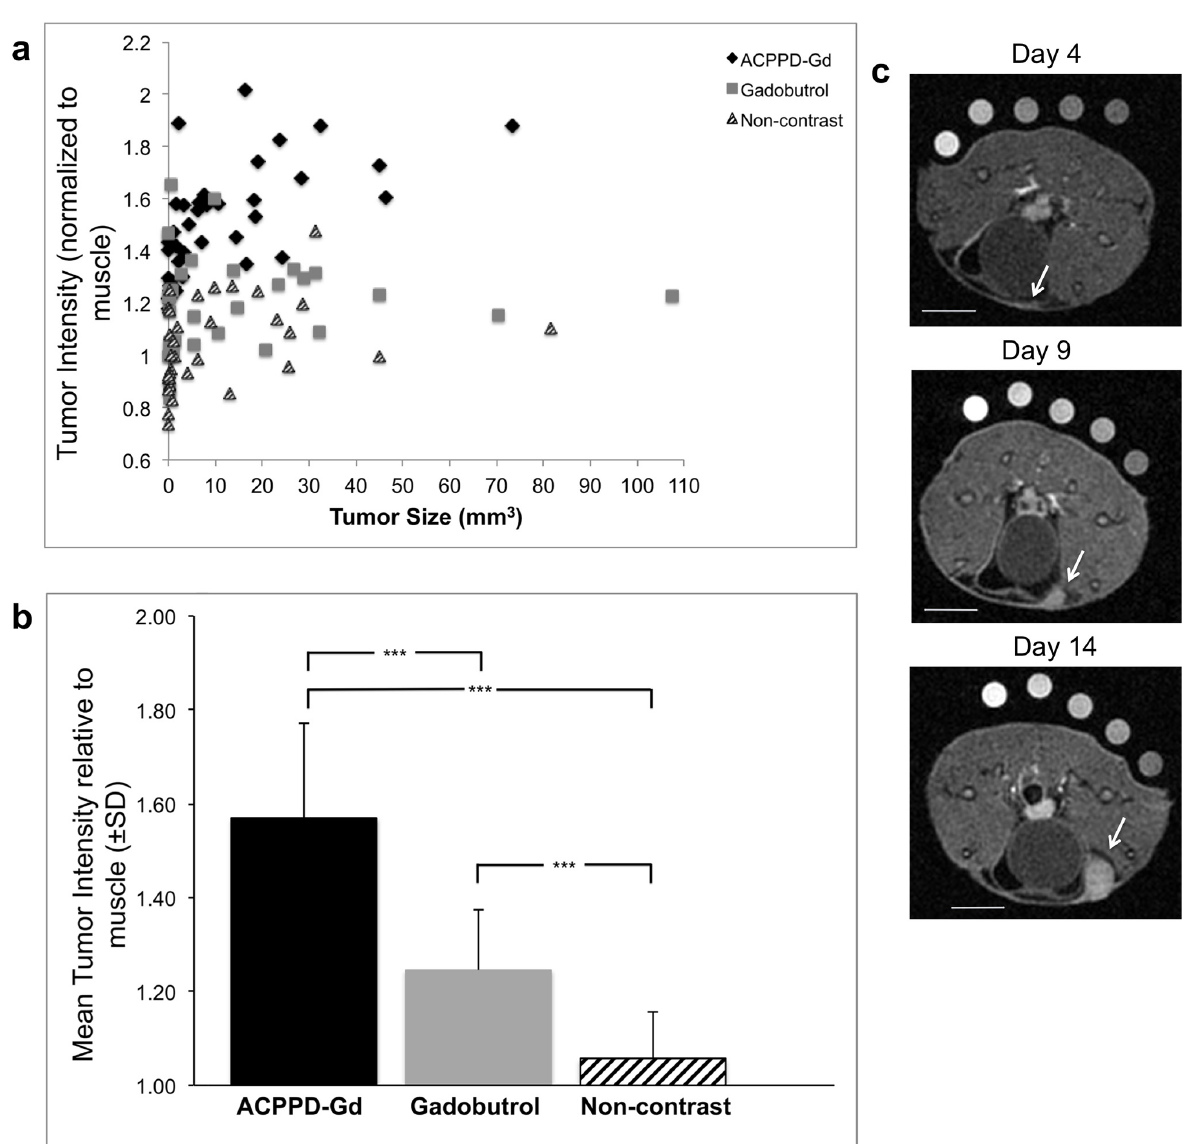
Fig 2. Tumor size and enhancement of all tumors. a , The normalized signal of all 107 tumors is shown as a function of tumor size that ranged from 0.03 to 107.4 mm 3 . Note that tumor enhancement was consistently greater for ACPPD-Gd animals at all tumor sizes. b , Bar graph of normalized mean enhancement ± SD of tumors > 1mm 3 shows that ACPPD-Gd caused the greatest enhancement. *** indicates p < 0.001. c , Representative axial fat-saturated T1w MR images of a tumor bearing mouse given ACPPD-Gd and imaged on days 4, 9, and 14 after inoculation showing a thin strip of enhancement on day 4 (arrow) at the site where the tumor became apparent on days 9 and 14 (arrow). This was not observed in the gadobutrol group (not shown). Scale bars = 5mm for each